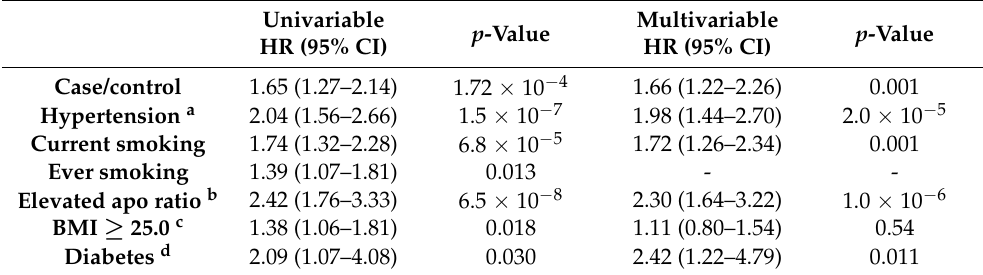
Table 2. Impact of various risk factors identified before RA symptom onset for the development of a cardiovascular event after